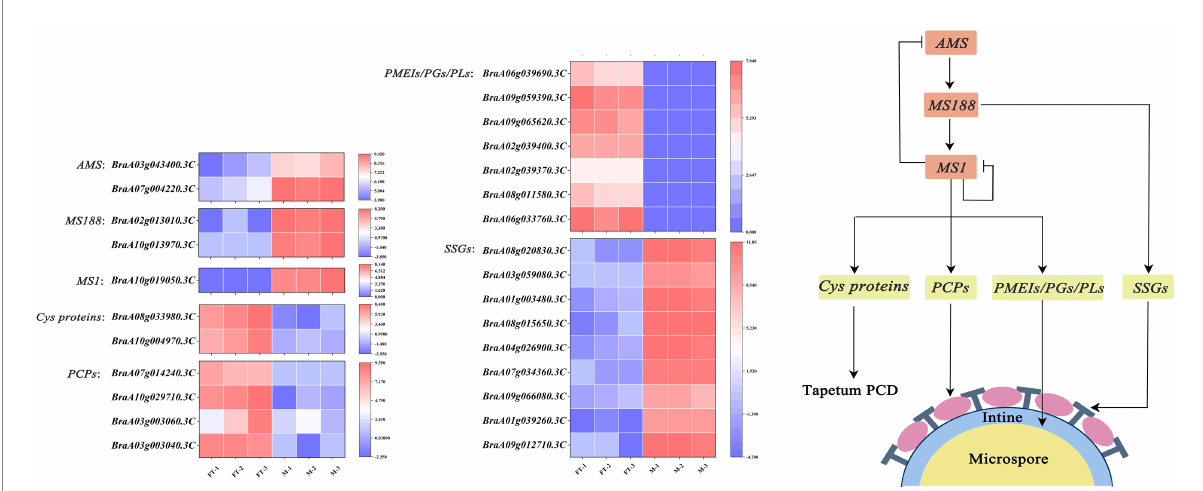
FIGURE 12 Proposed working model for BrMS1 regulation of male fertility in Chinese cabbage. MS1 which encodes a PHD-finger transcription factor could regulate the tapetum programmed cell death by influencing the transcription level of Cys proteins. MS1 functions in pollen coats and pollen intine formation by mediating the expression of related genes in anthers. In addition, MS1 could negatively regulate the transcription level of itself and the upstream regulator AMS , which in turn affects the expression of SSGs to control the formation of pollen exine. MS1 plays an important role as a downstream regulator in the male fertility regulatory